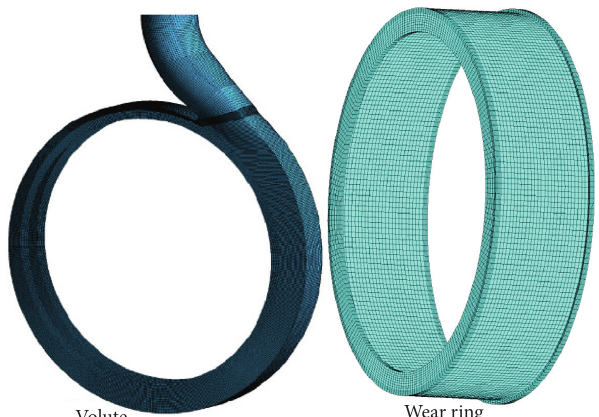
Figure 3: A generated mesh of selected flow domain.